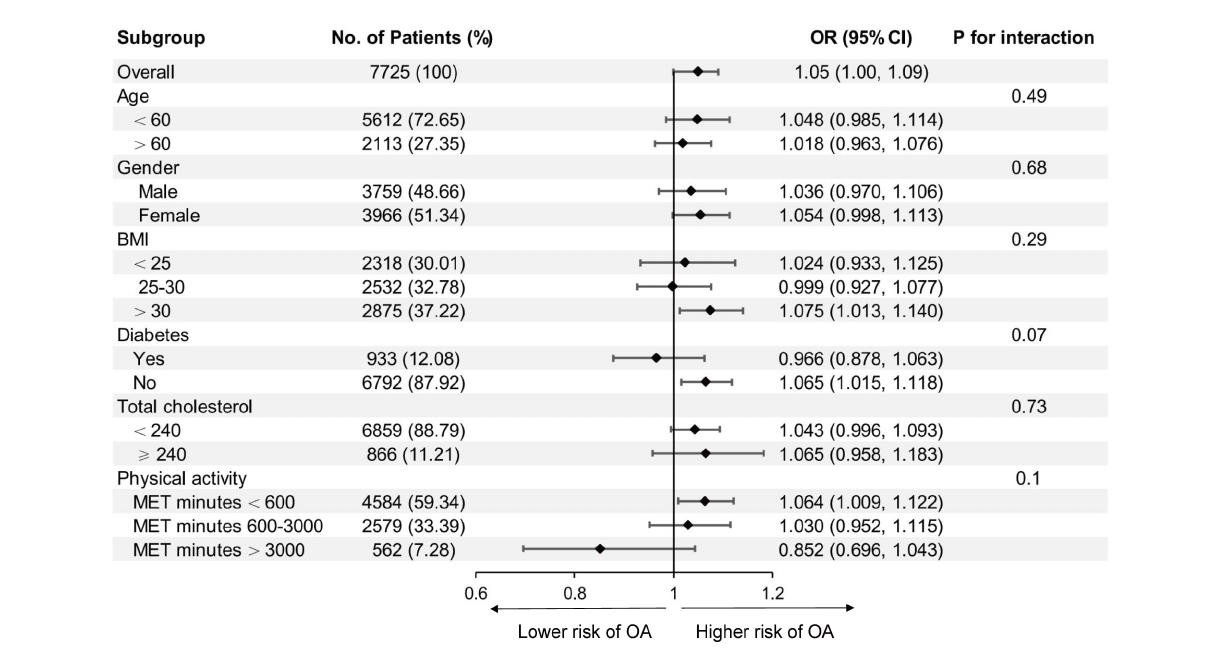
FIGURE2 Association between isocaloric substitution of fat for carbohydrate intake with osteoarthritis (OA) risk in different subgroups. BMI, body mass index; MET, metabolic equivalent task. Age, gender, race/ethnicity, education, diabetes, body mass index, total protein, total cholesterol, serum calcium, serum 25-hydroxyvitamin D, metabolic equivalent task minutes, dietary fiber intake, total energy intake, and protein intake were adjusted (the stratified variable was omitted from the